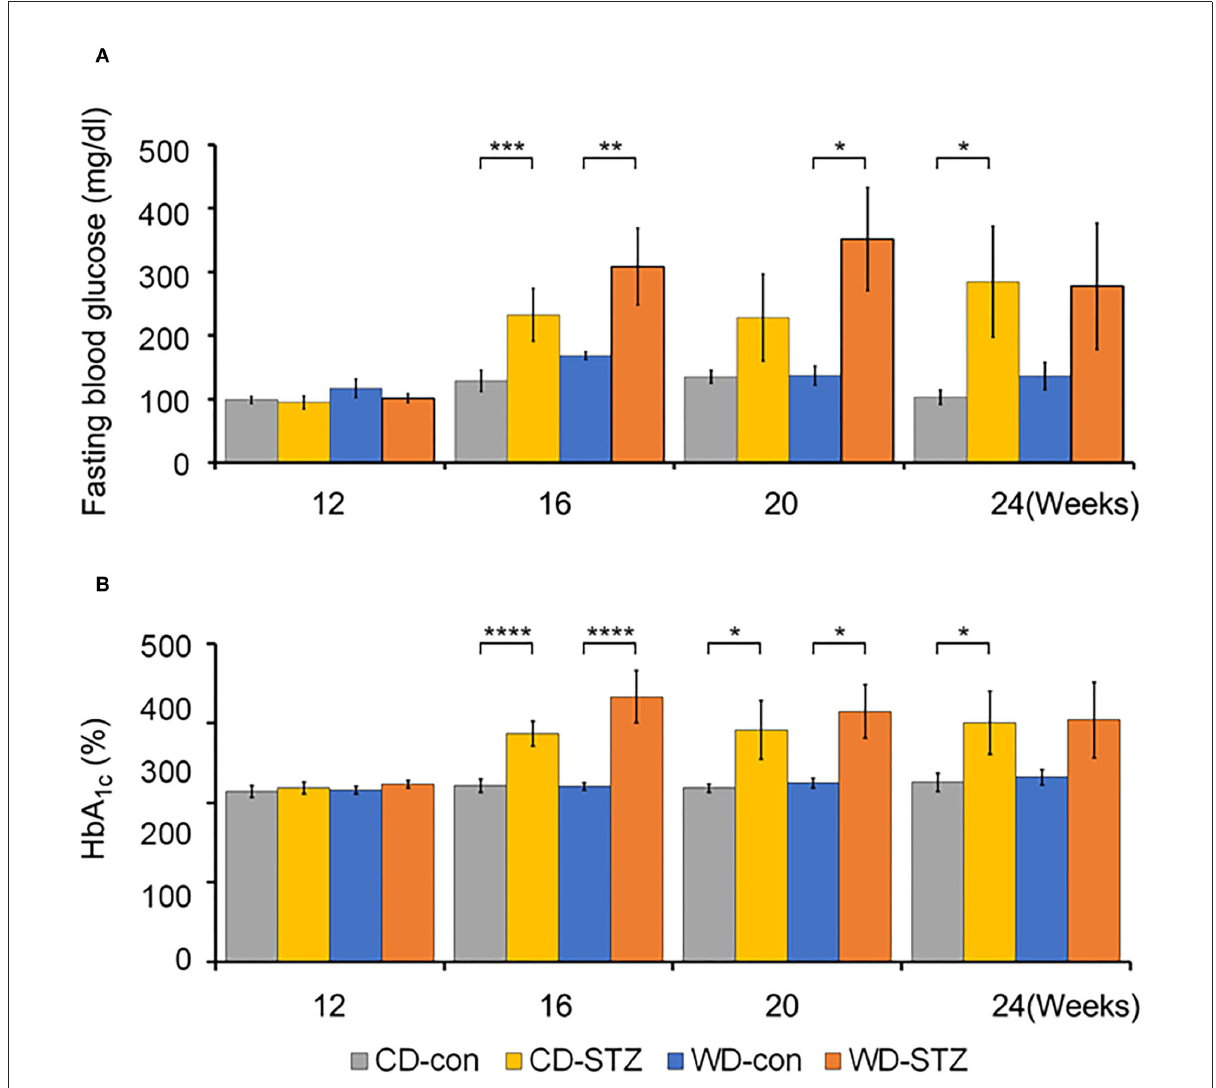
FIGURE3 Fasting blood glucose and hemoglobin A 1c (HbA 1c ) levels. (A) Increased fasting blood glucose levels in STZ-treated mice at 16 weeks of age. Blood glucose levels were checked in all groups after 6 hours of fasting. (B) Hemoglobin A1c (HbA 1c ) levels in all groups of mice at 16, 20, and 24 weeks of age. * p < 0.05, ** p < 0.01, *** p < 0.001, and **** p <